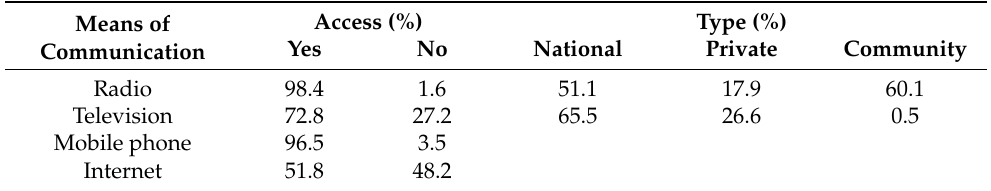
Table 3. Proportions of people receiving agrohydroclimatic information according to the means of dissemination and communication available in the surveyed